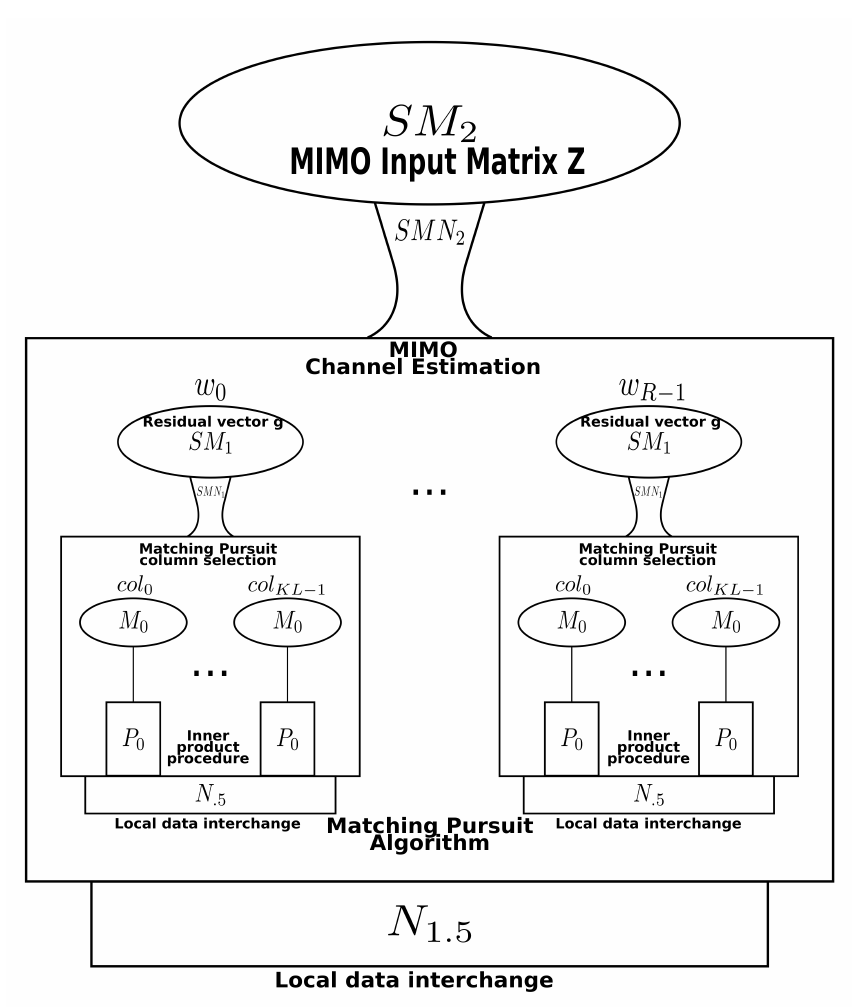
Figure 6. Kuck’s diagram for the parallel MIMO acoustic, linear, stochastic (ALS) estimation